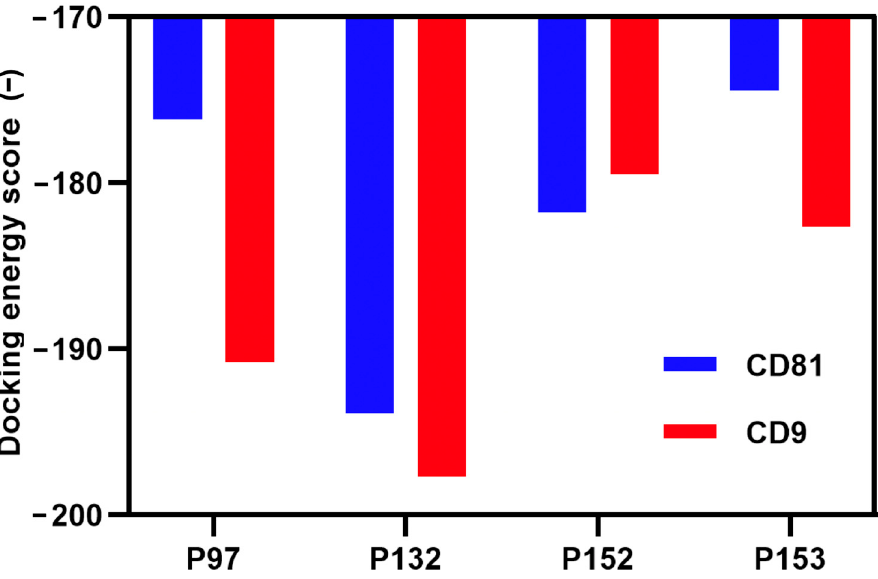
Figure 3. Docking energy scores of CD81-BP candidates for CD81 and CD9 proteins were assessed using a hierarchical algorithm − based web server, HPEPDOCK, for blind peptide–protein docking [23].